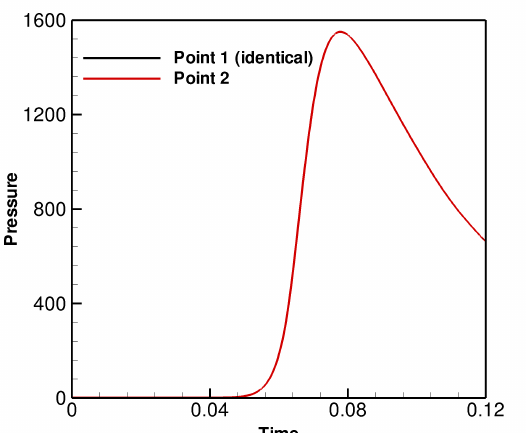
Figure 3. The pressure history recorded at the boundaries of the computational domain for an initially spherical bubble (Scenario 1). Point 1 is located at the position (0.5, 0.0, 0.0), and the position of Point 2 is (0.0, 0.0, 0.5).